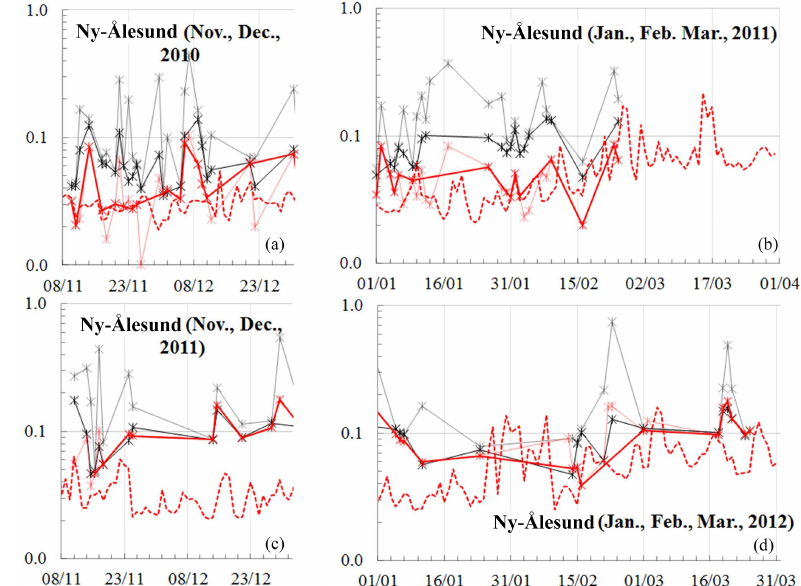
Figure 2. Same as the legend of Fig. 1 but for